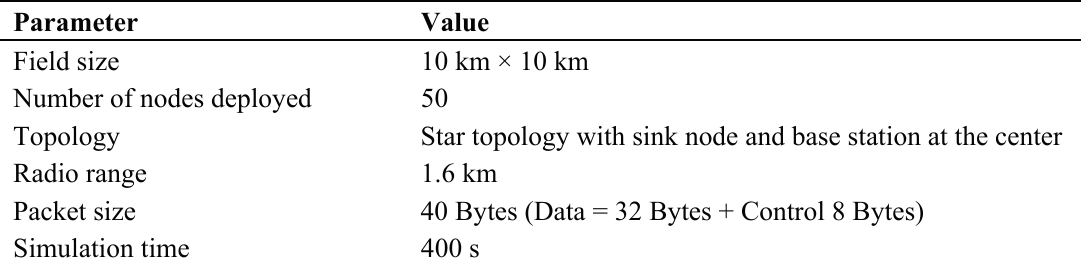
Table 1. Simulation parameters and their